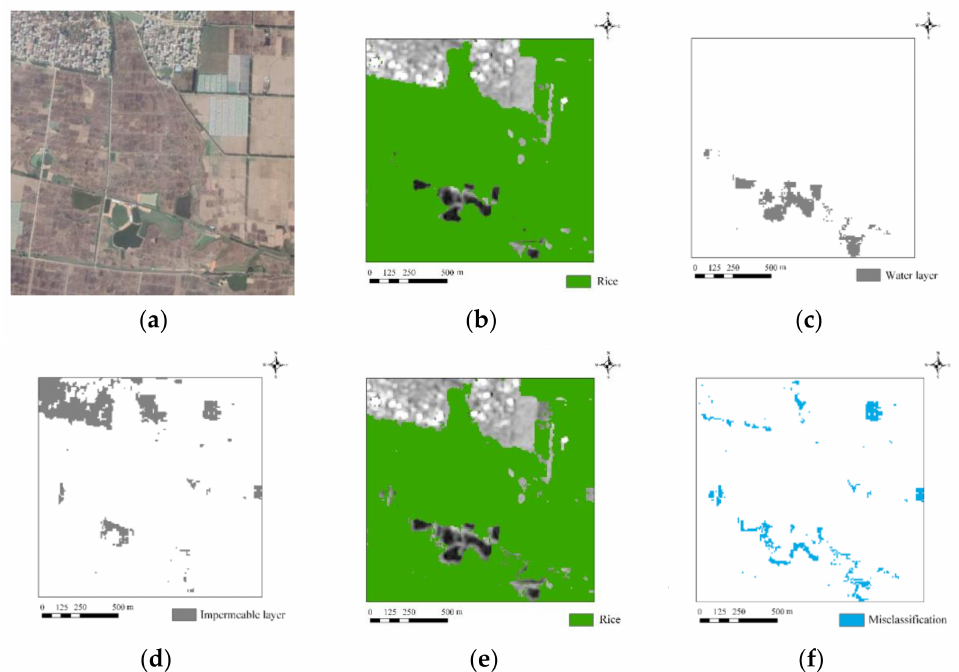
Figure 12. An example of optimization of classification results using FROM-GLC10 data. ( a ) The optical image; ( b ) original classification results; ( c ) the water layer; ( d ) the impermeable layer; ( e ) optimized classification results; ( f ) removed false alarms.